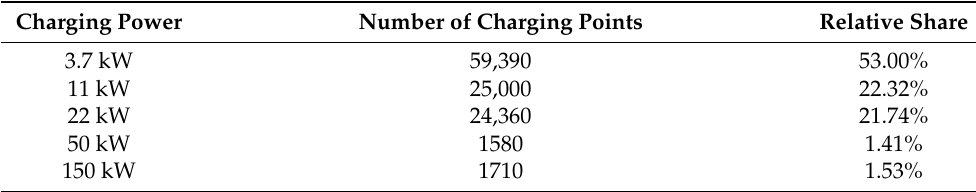
Table 7. Charging points per power of the bottom-edge